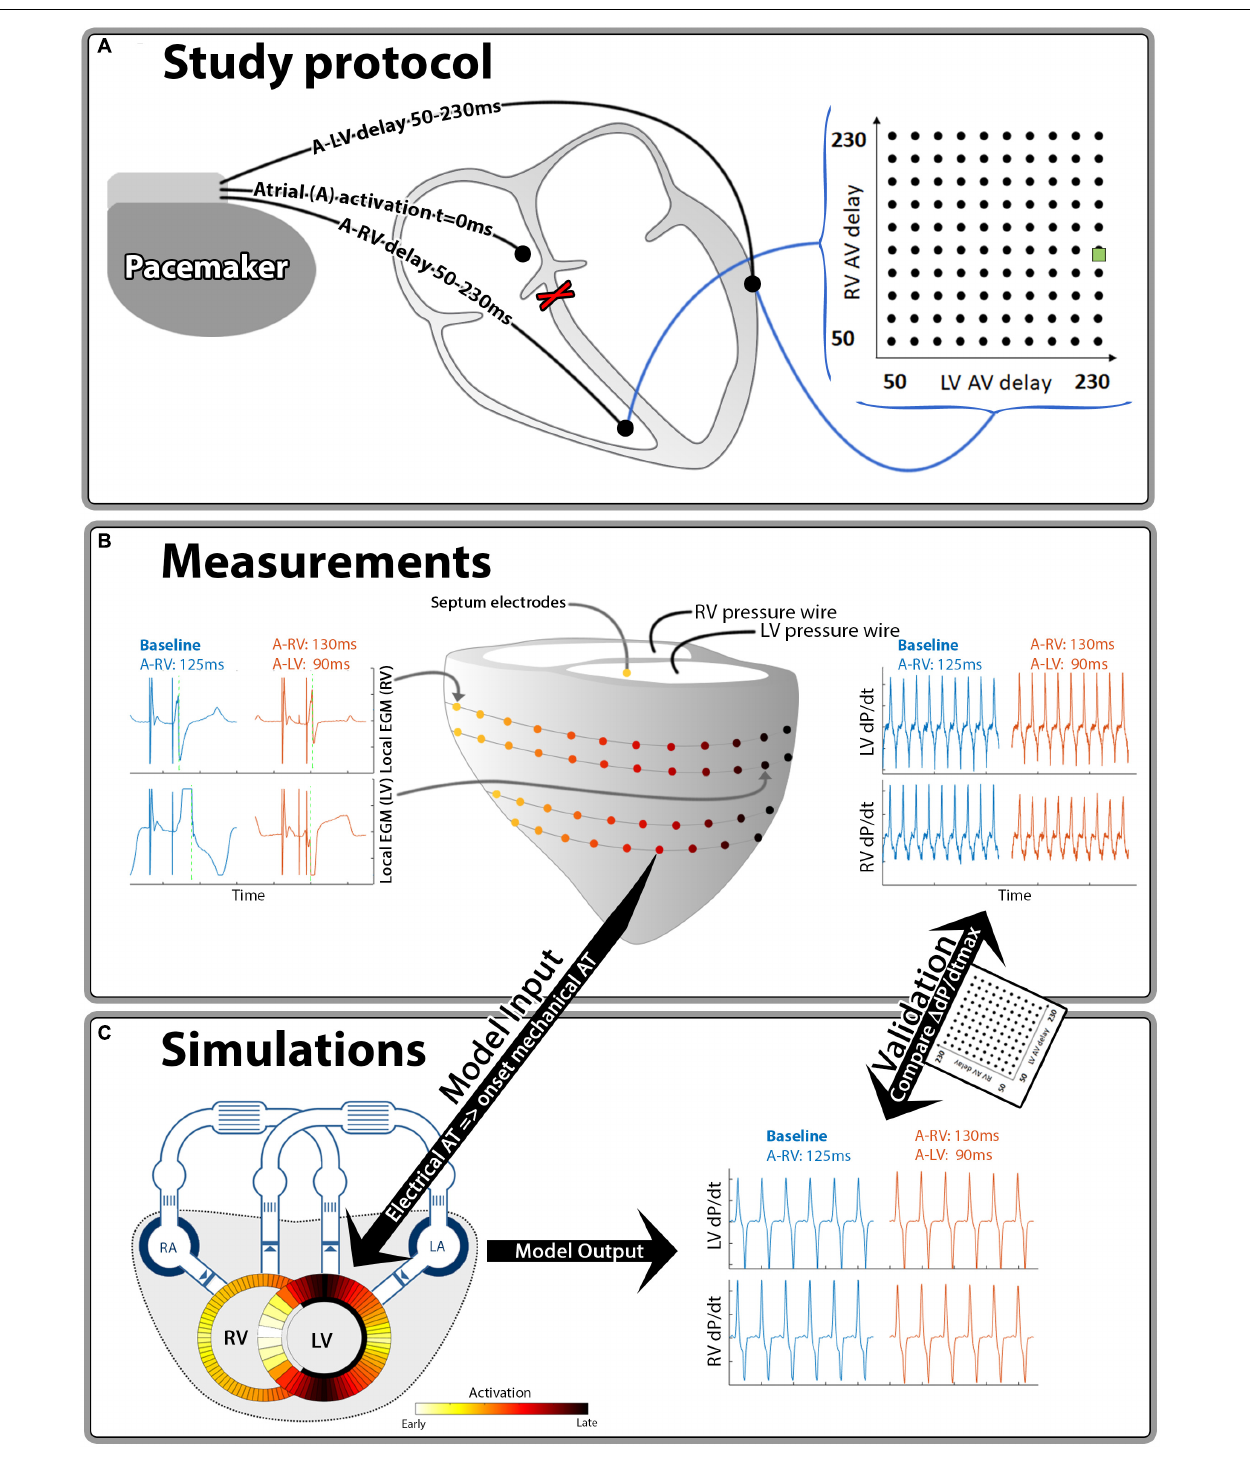
FIGURE 1 | Schematic representation of the methods used in this study. Hundred different A-LV/A-RV pacing delay combinations were programmed (A) while pressures and local electrical activation were measured (B) . Generic activation maps, derived from local electrograms, were used as onset of mechanical activation in the computer simulations (C) . The resulting output of the simulations and measurements was compared for validation purposes. The green square in the heat maps indicates the baseline pacing setting.